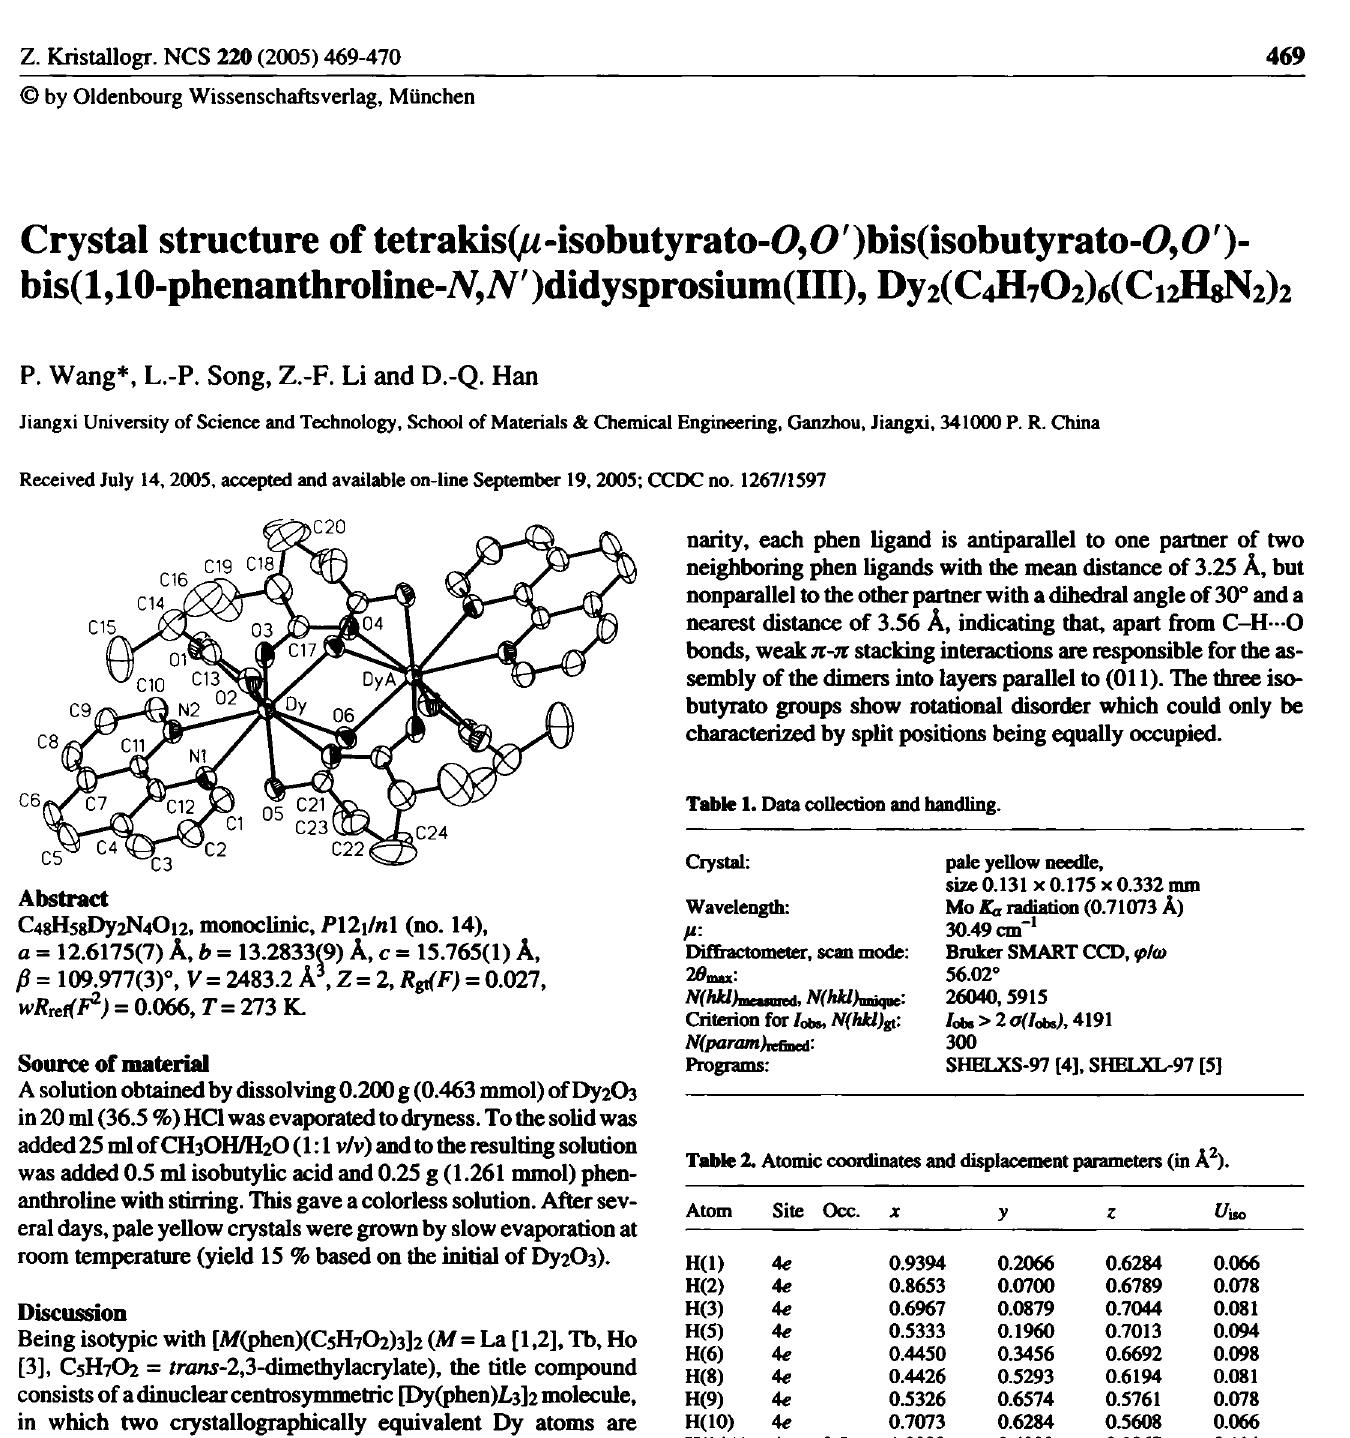
Table 2. Atomic coordinates and displacement parameters (in A 2